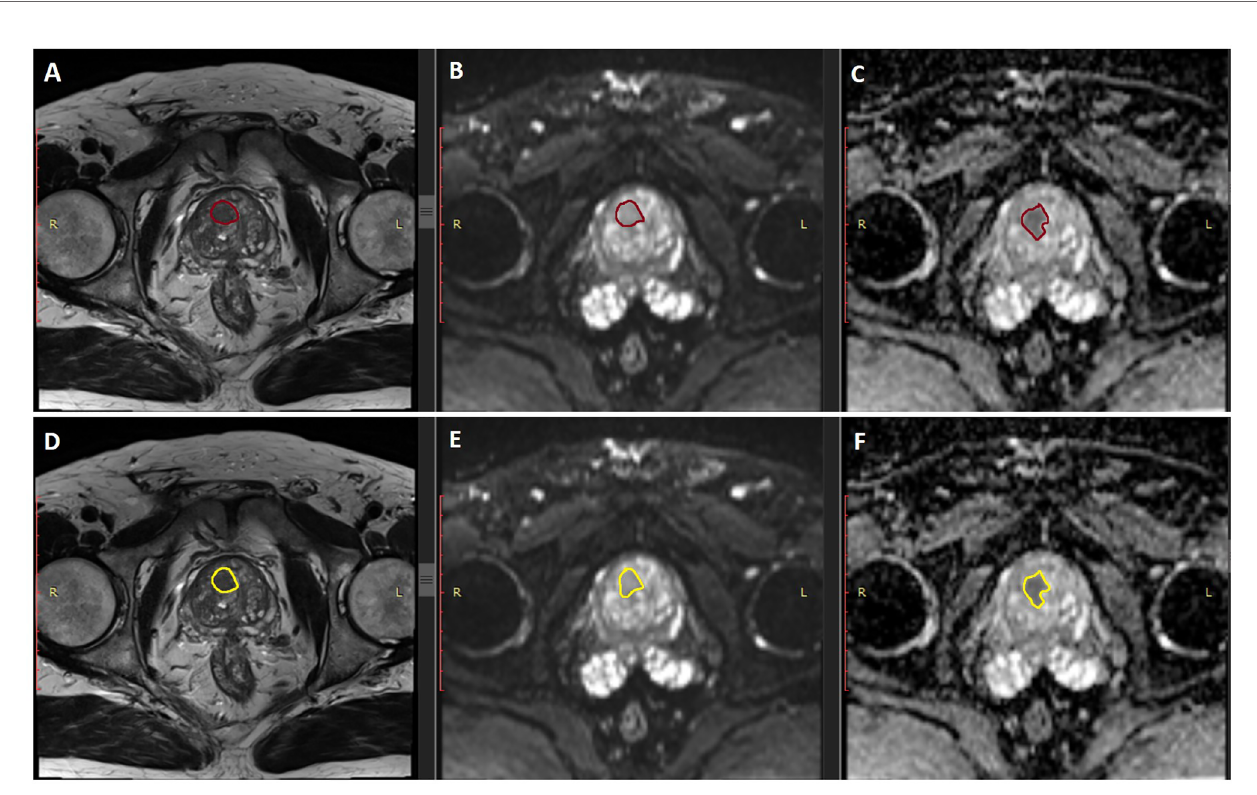
FIGURE 1 | Examples of the two segmentation of the two operators. Panels (A – C) represent the examples of segmentation (in burgundy) of the fi rst operator, in the T2, DWI. and ADC MRI sequences, respectively. Panels (D – F) represent the examples of segmentation (in yellow) of the second operator, in the same sequences,